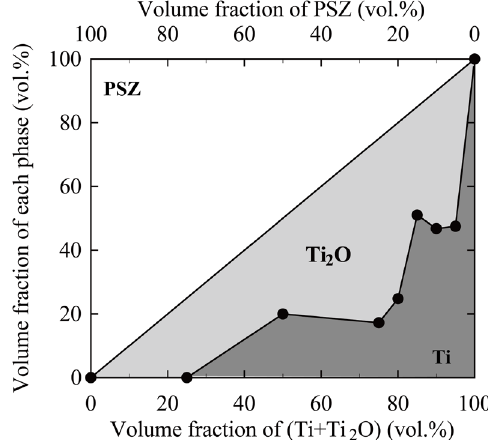
Figure 11. Estimation of volume fractions of phases in PSZ-Ti composites fabricated via SPS.